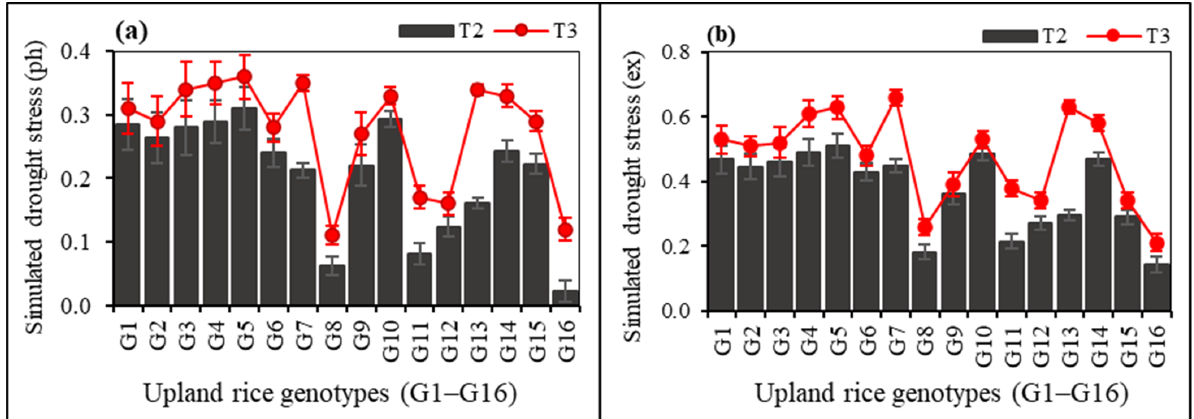
Figure 7. Simulated average drought stress for photosynthesis [ph] ( a ), and growth expansion [ex] ( b ) for sixteen upland rice genotypes under T1: control (100% FC), T2: moderate stress (70% FC) and T3: severe stress (50% FC) treatments in yield assessment experiment. Vertical bars indicate ± standard errors of average values of drought stresses, simulated for treatment duration.